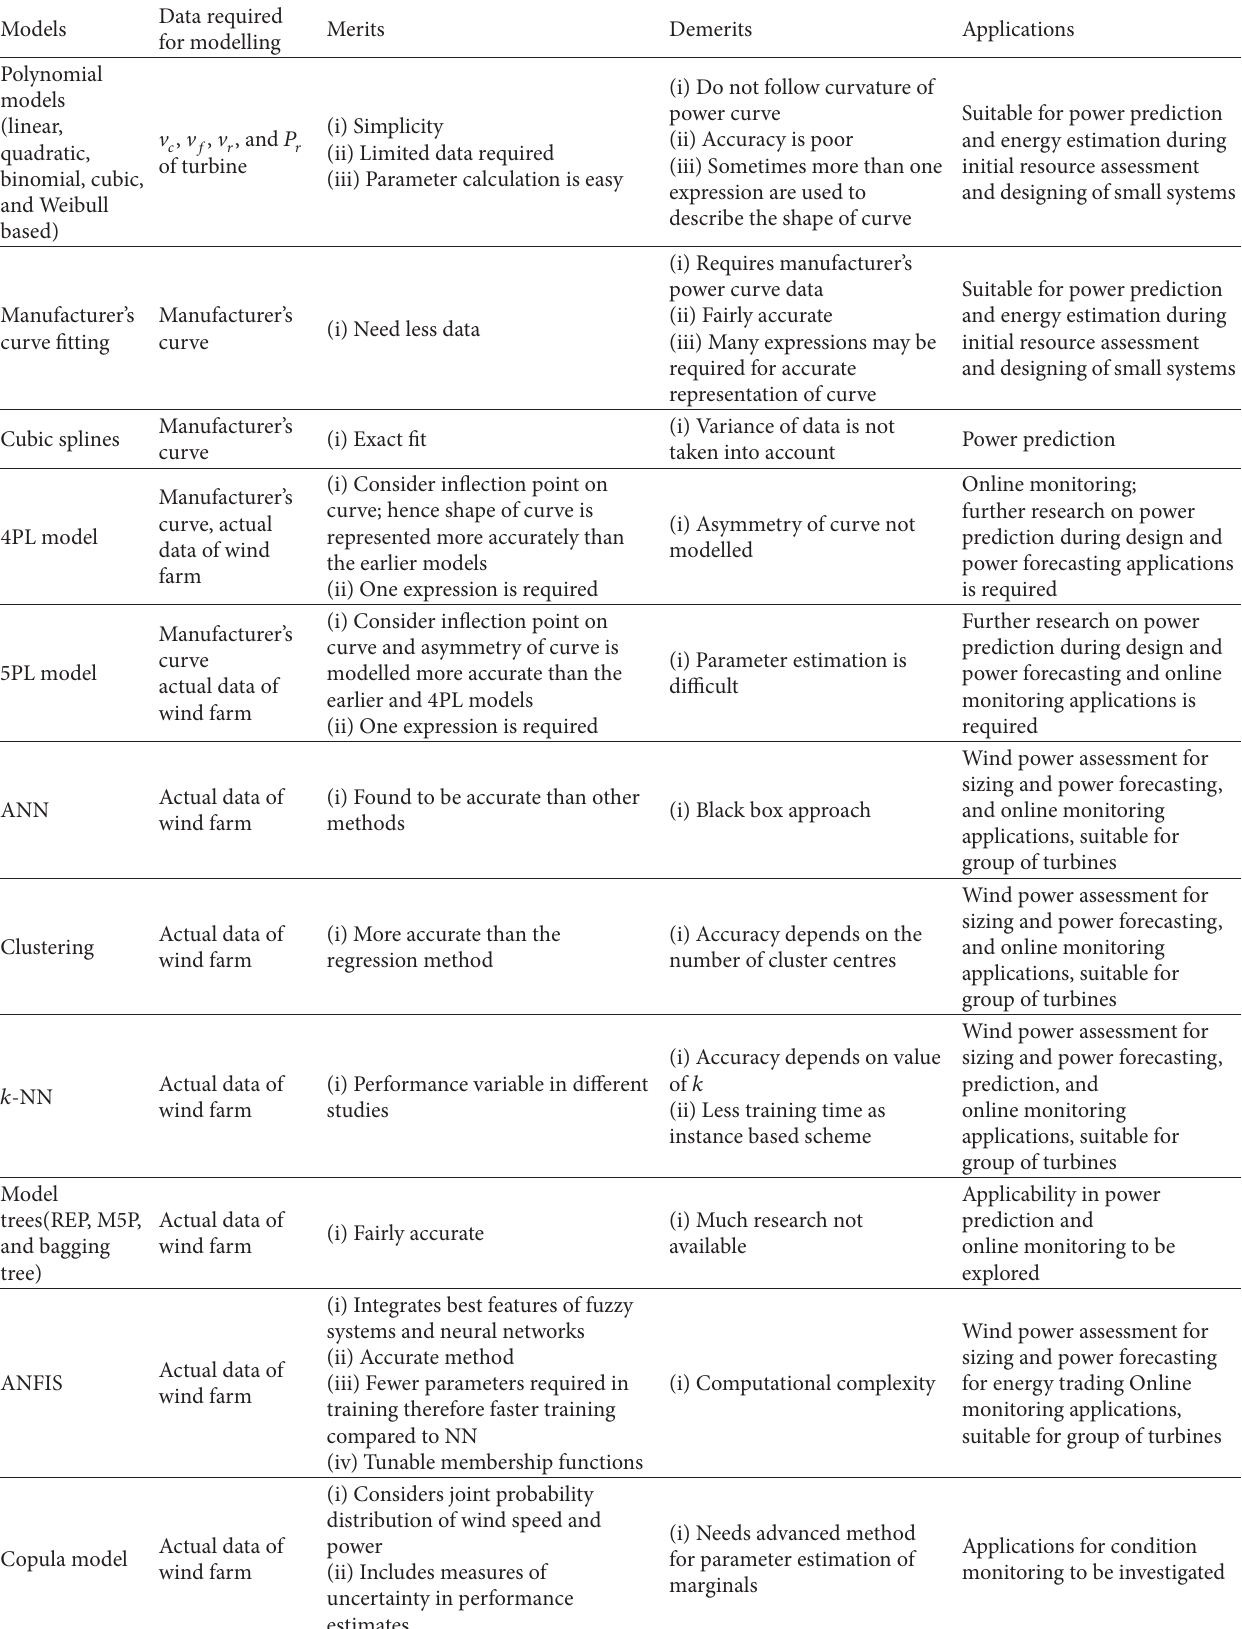
Table 5: Comparison of modelling